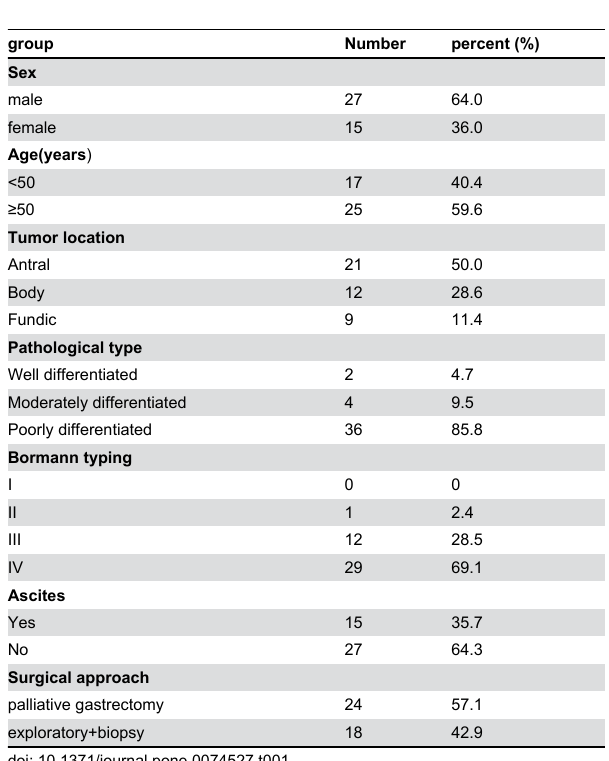
Table 1. Clinical and pathological characteristics of 42 cases of patients with gastric